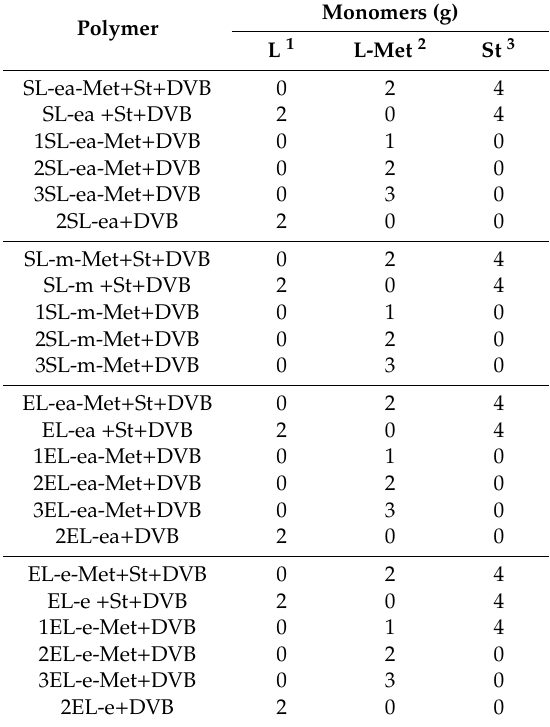
Table 1. Experimental parameters of the